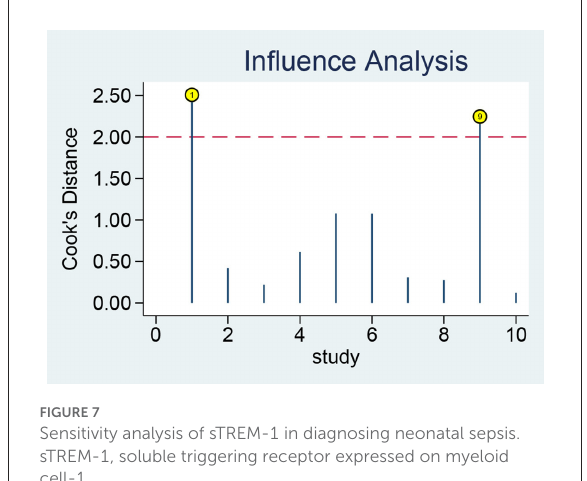
FIGURE7 Sensitivity analysis of sTREM-1 in diagnosing neonatal sepsis. sTREM-1, soluble triggering receptor expressed on myeloid